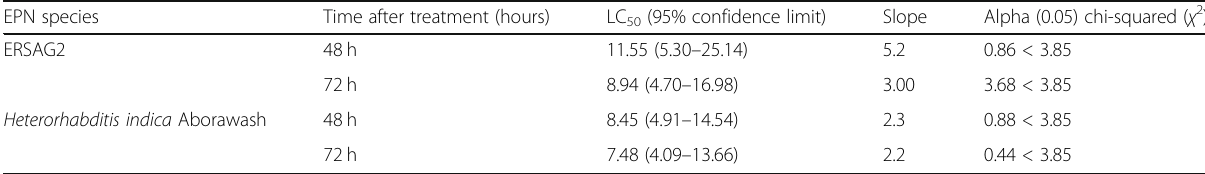
Table 1 Calculated LC 50 values (IJs/larva) for ERSAG2 and Heterorhabditis indica Aborawash on larvae of G. mellonella EPN